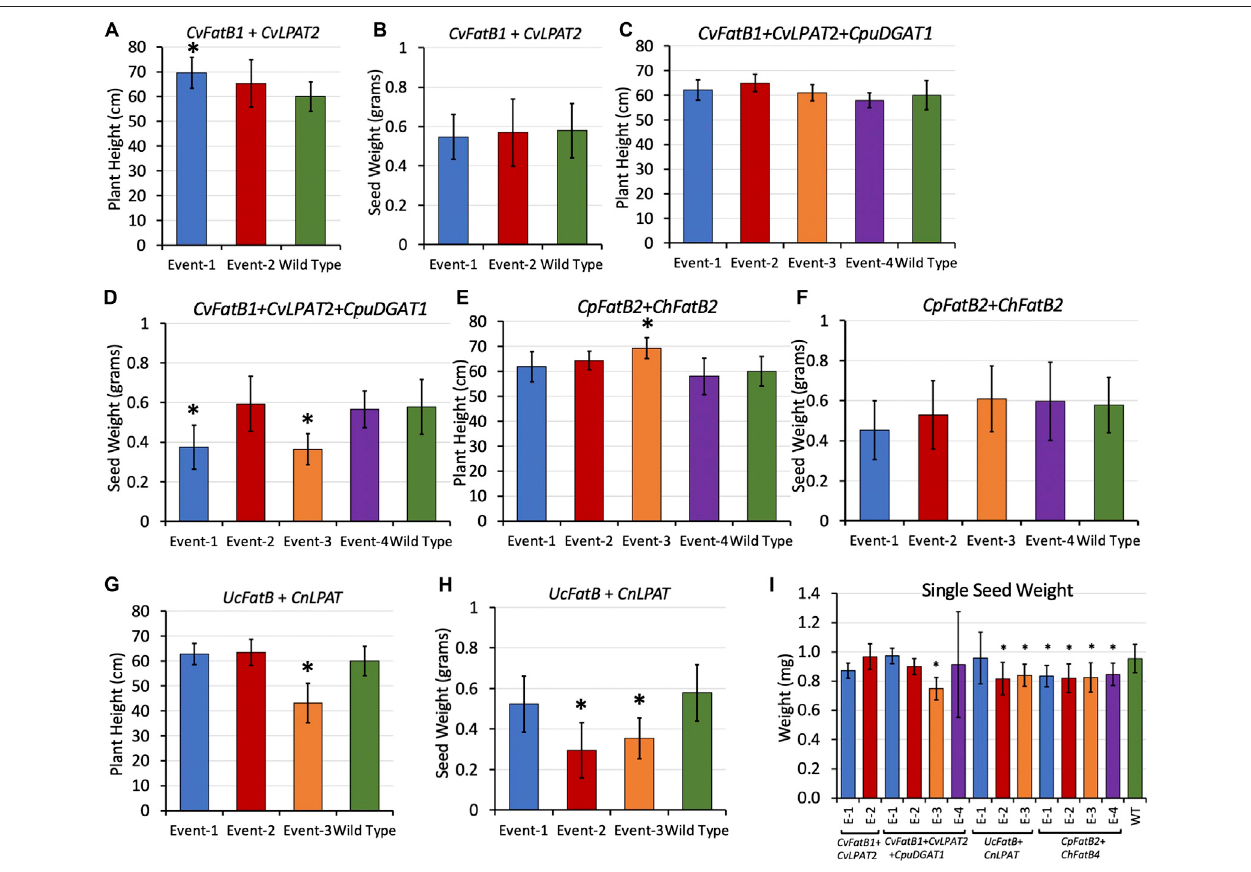
FIGURE4| Average heights (A,C,E,G) ofT 2 -generation plants atmaturity,averagetotal weights (B,D,F,H) oftheT 3 seedsthoseplants produced, and (I) average weight per seed for each line. “ Event ” stands for each line arising from an independent transgenic insertional event. Bars are standard deviation. Asterisks delineate averages that were signi fi cantly different from that of wild type grown alongside ( p < 0.05 as determined by t -test). For (A – H) , n (cid:1) 8 biological reps. For (I) , from 1,519 to 5,532seedsweremeasuredperplant,5 – 11biologicalreps.Heightsandtotalseedweightsofindividualplantscanbefoundin SupplementaryFiguresS8 – S15 .